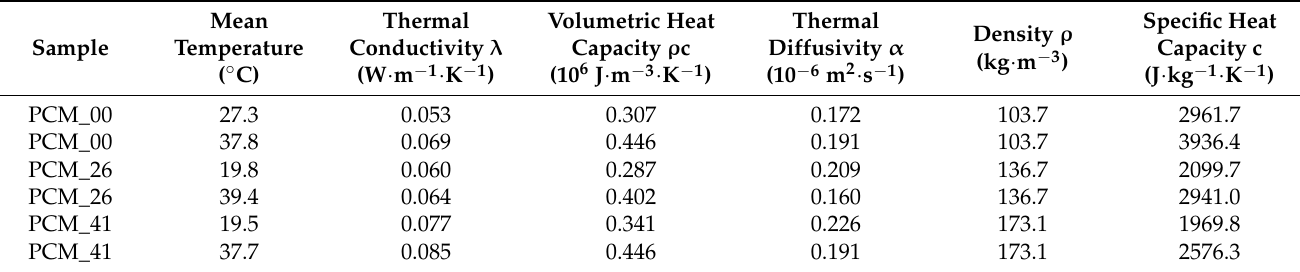
Table 3. Mean values of thermal